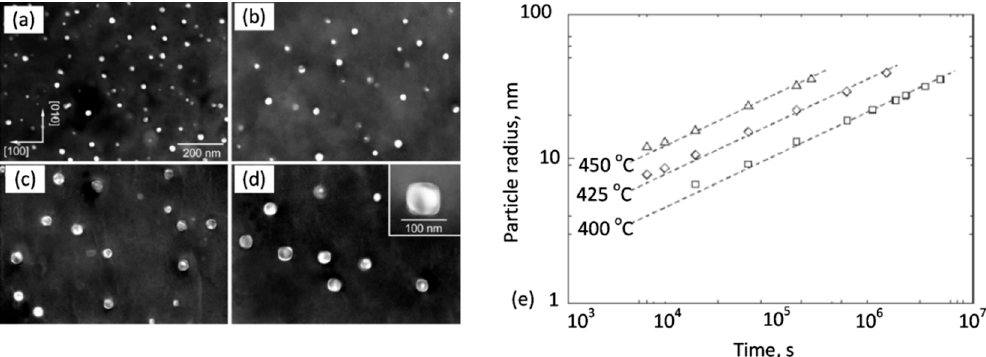
Figure 10. Precipitate coarsening during aging of Al − 0.28 wt.% Sc alloy: dark-field TEM images of Al 3 Sc precipitates aged at ( a ) 400 °C for 5 h, ( b ) 400 °C for 50 h, ( c ) 425 °C for 50 h, and ( d ) 450 °C for 50 h; ( e ) change in the average precipitate radius r with aging time t for temperatures indicated [41].